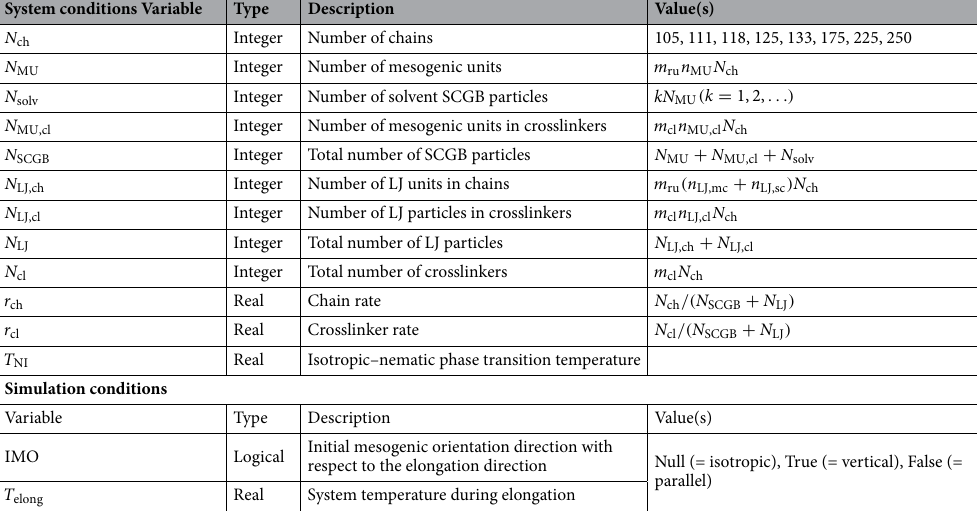
Table 2. Variables for the system and simulation conditions of the LCE molecular